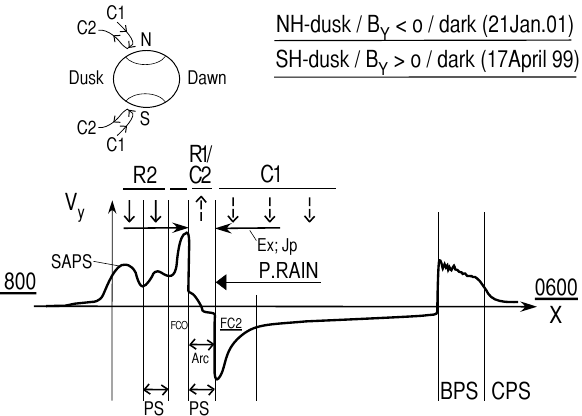
Fig. 26. Schematic illustration of DMSP F13 cross-track (horizon- tal component) ion drift profile ( V y ) along the dusk-dawn merid- ian in the context of particle precipitation and Birkeland current regimes (vertical guidelines) for event categories NH-dusk/ B y < 0 and SH-dusk/ B y > 0. Not to scale.